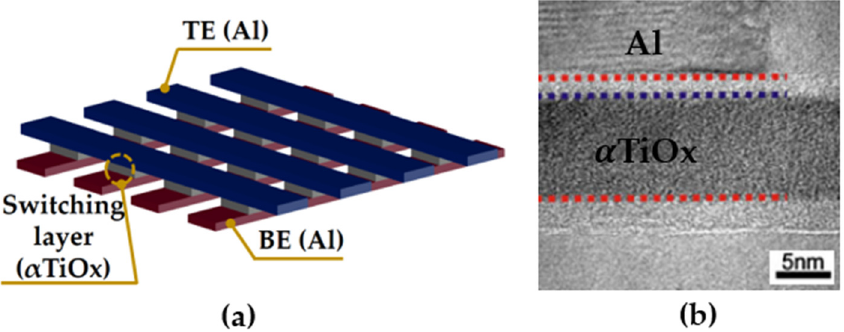
Figure 1. ( a ) The simple structure and ( b ) the cross-sectional TEM image of the fabricated Al/ α TiO x /Al RRAM device.